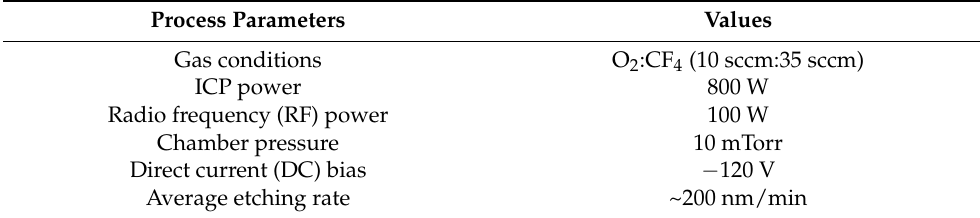
Figure 5. Schematic process of manufacturing 4H-SiC piezoresistive pressure sensor chip. Table 2. Process parameters inductive coupled plasma (ICP)